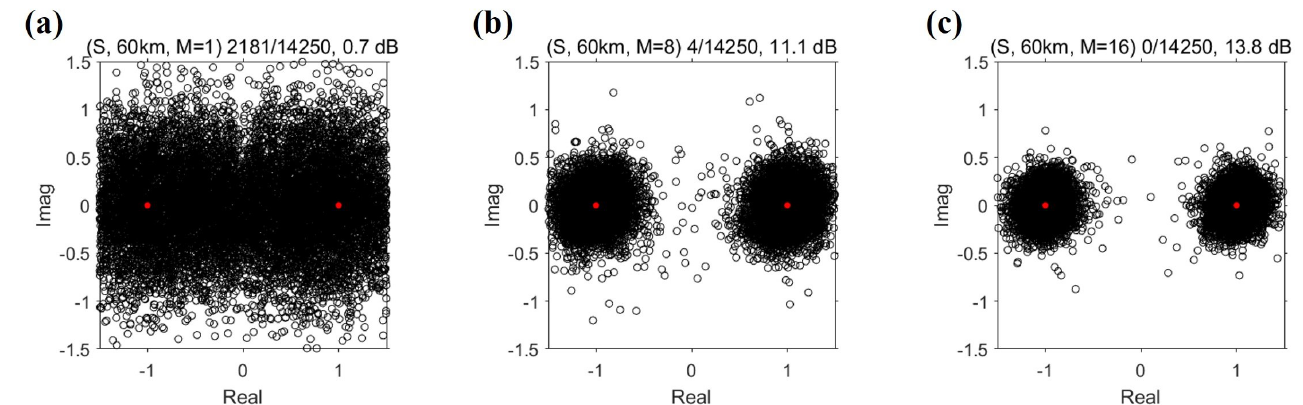
Figure 8. Scatter plots according to the order of spatial diversity ( M ): ( a ) M = 1, ( b ) M = 8, and ( c ) M = 16. As the order of spatial diversity increases, the communication performance, in terms of BER and output SNR, improves. This is consistent with the sidelobe variation of the averaged